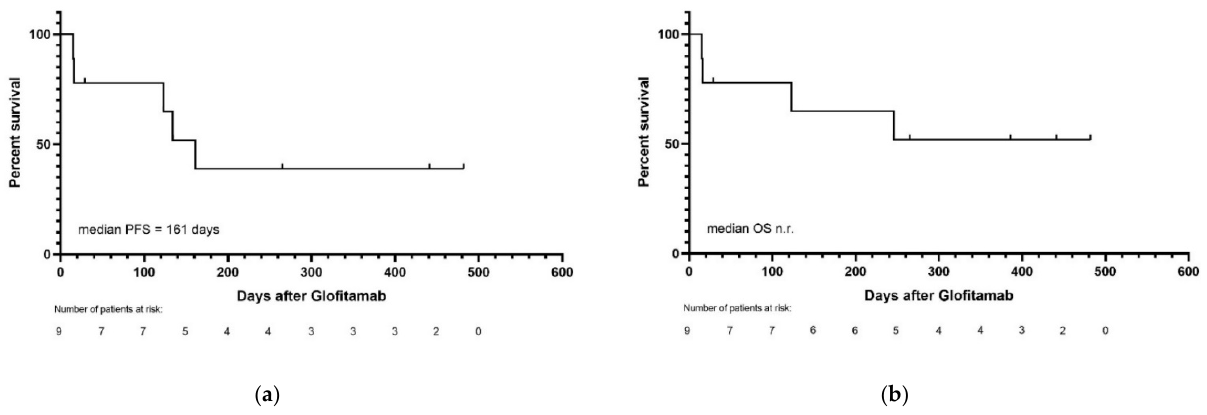
161 days, and median OS was not reached. PFS and OS are presented in Figure 3.